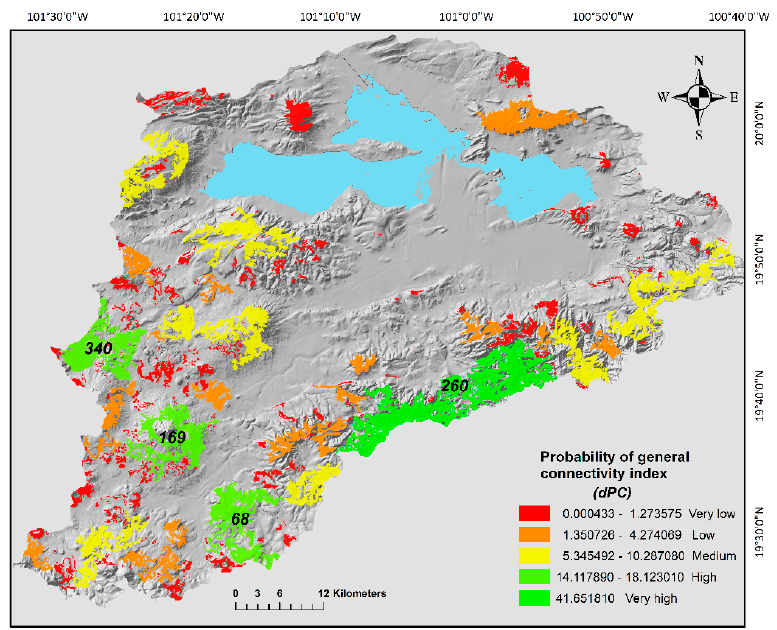
Figure 3. Probability of general connectivity index ( dPC ) between oak forest fragments in the Cuitzeo Lake Basin. Levels of importance for the general connectivity index are shown in the figure; this classification was based on the Jenks optimization model. In the map are shown the id of the four patches with the highest importance to general connectivity. Table 3. The oak forest patches with the largest contribution to connectivity in the Cuitzeo Lake basin. In the table are shown the identification of the patch, its area and the contribution of each patch